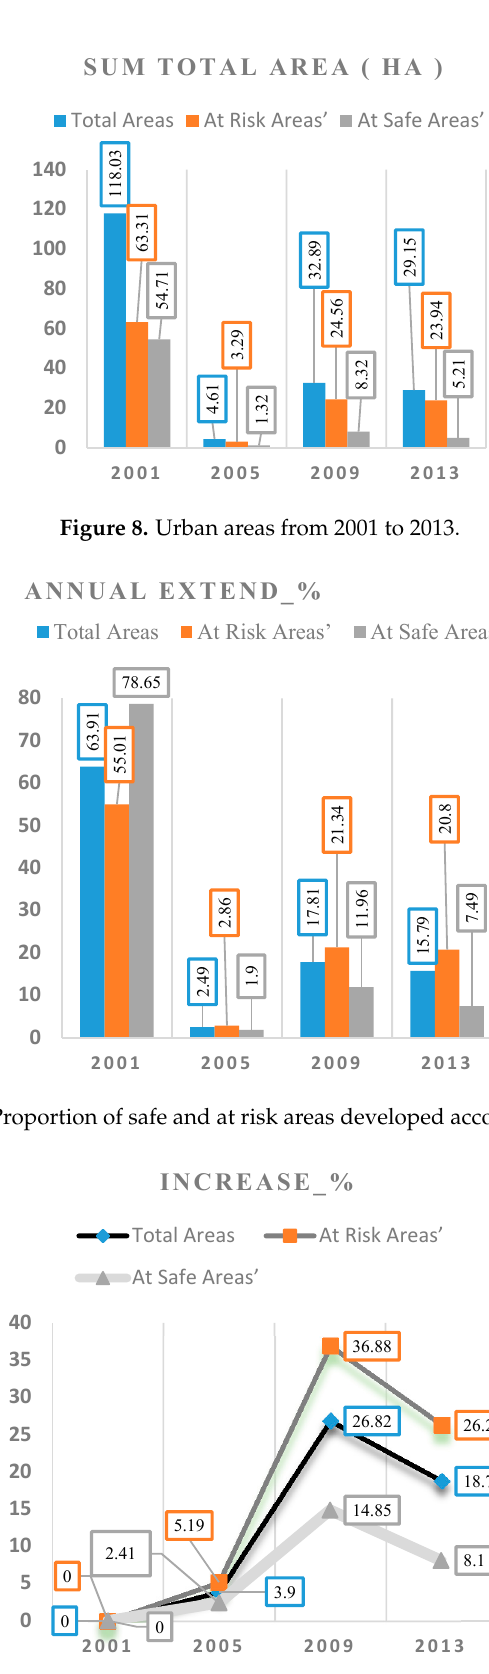
Figure 10. Annual rate of increase in developed safe and at risk